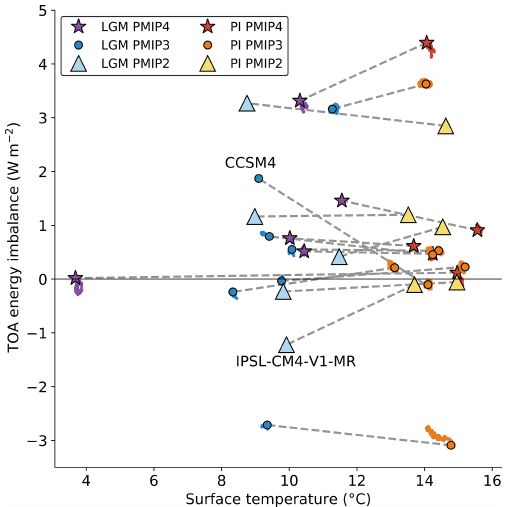
Figure 4. Surface temperature ( ◦ C) and top-of-atmosphere (TOA) radiation imbalance (Wm − 2 ) drift in PMIP models simulating LGM (blue scale) and pre-industrial (PI, orange scale) states. Each trail is a 30-year running mean, while the symbol is a mean of the last 30 years of the time series, when applicable. The gray line con- nects the LGM and piControl simulation of each model. Note that for PMIP2 models and CCSM4 for PMIP3, time series are not avail-